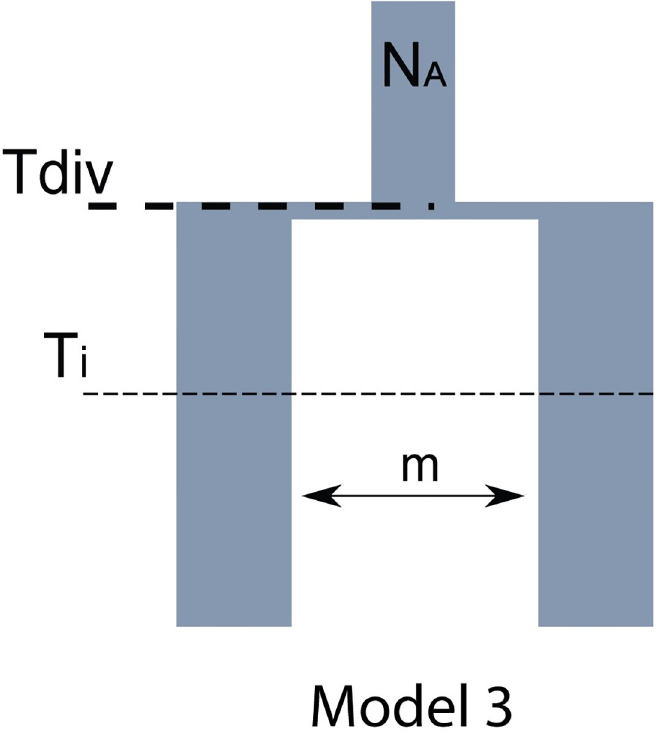
Fig 7. Results of demographic model comparisons between all populations. The best migration and species delimitation model generated from multidimensional site frequency spectrum inferred with FastSimcoal2 implemented in DelimitR. N A : Ancestral population, T div = Divergence time, T i = Time since isolation, m =